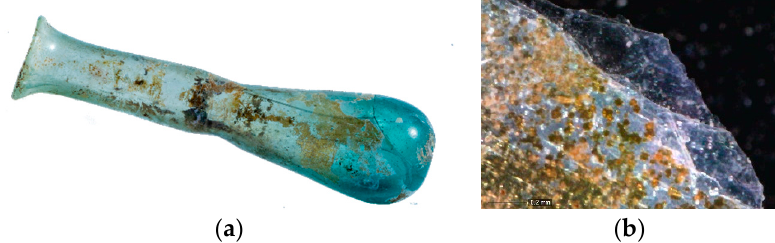
Figure 1. ( a ) Sample 1462. ( b ) Digital microscope image (120×) of a detached flake.